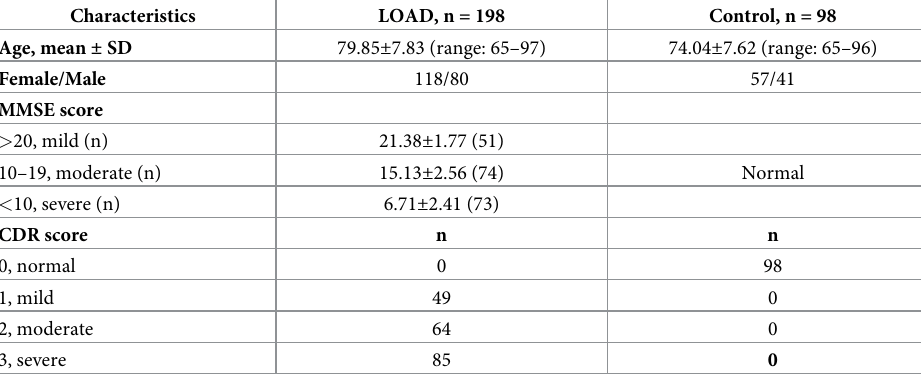
Table 2. Characteristics of the study